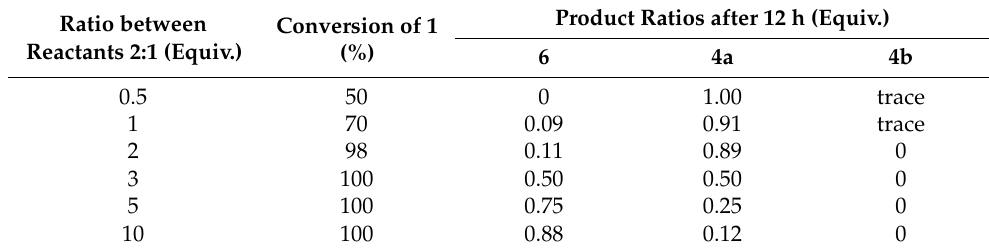
Table 2. Products ratio depending on the fraction of 2 .